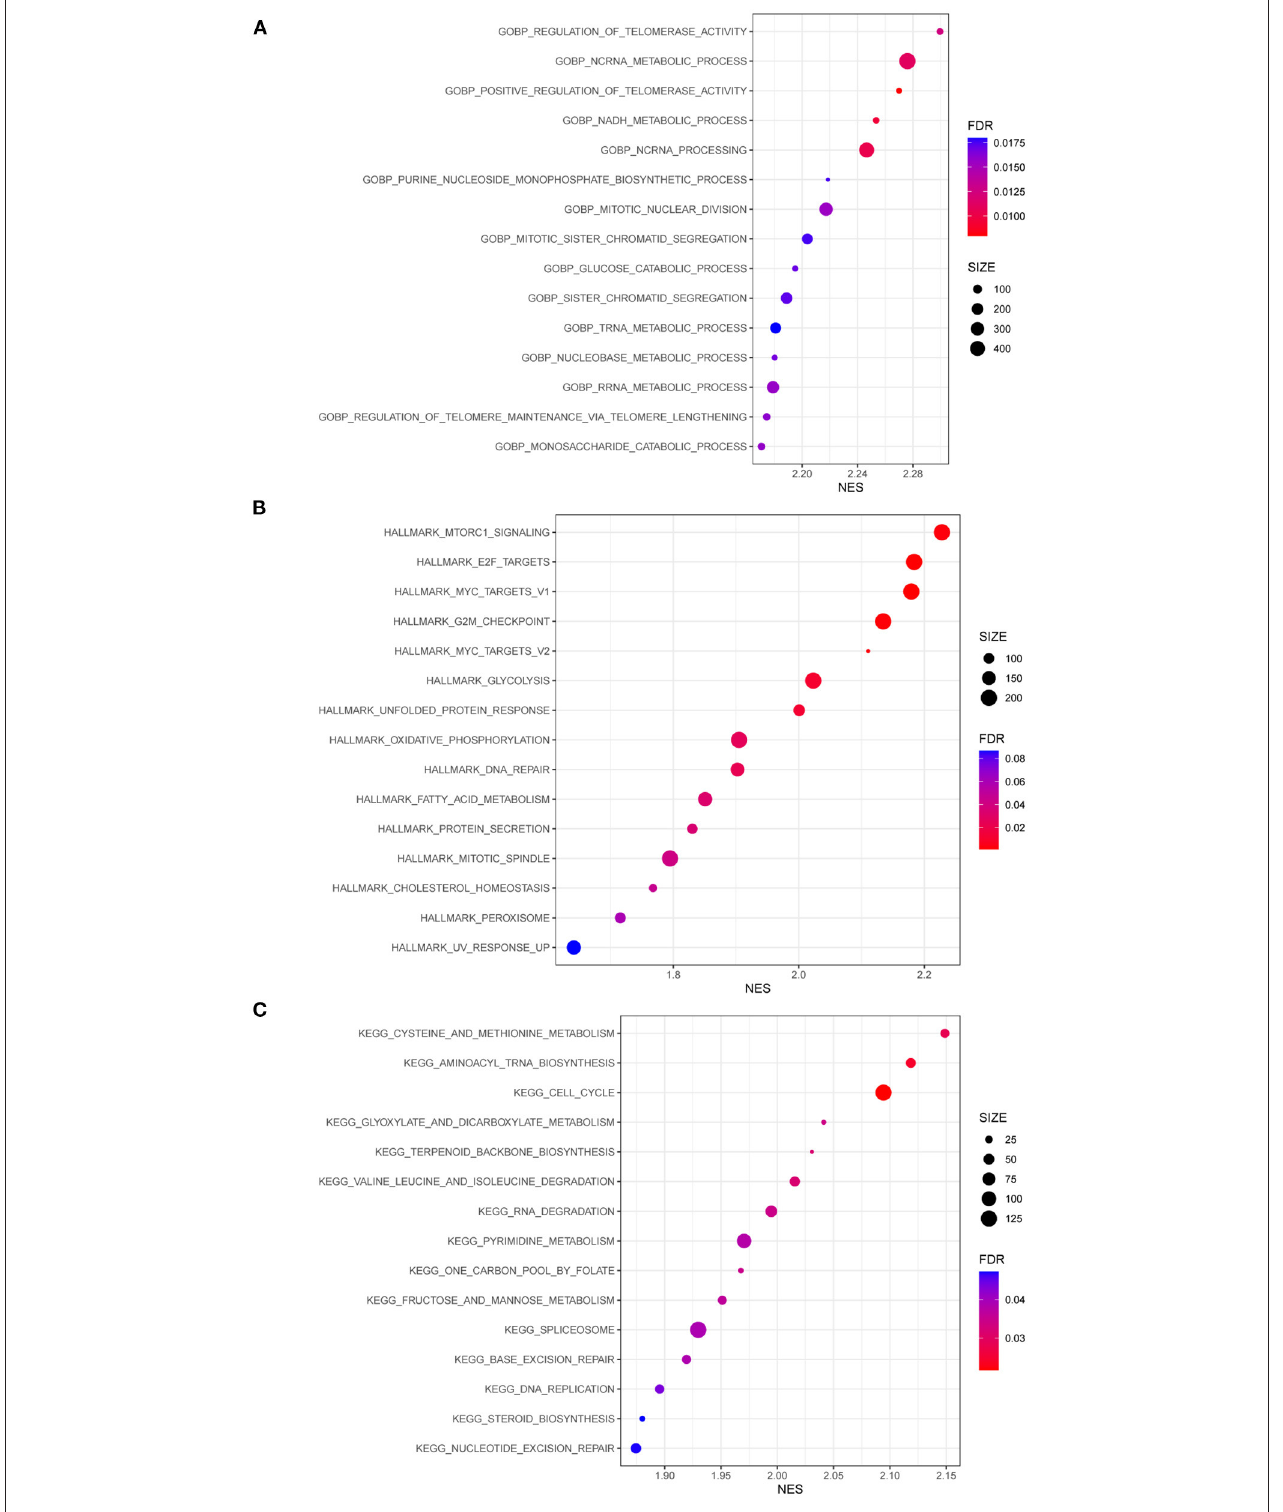
FIGURE 5 | GSEA results of patients with MUC16 mutation in TCGA-STAD cohort. (A) Enriched gene sets in GOBP collection. (B) Enriched gene sets in HALLMARK collection. (C) Enriched gene sets in KEGG collection. GSEA, Gene Set Enrichment Analyses; GO, gene ontology; BP, biological process; KEGG, Kyoto Encyclopedia of Genes and